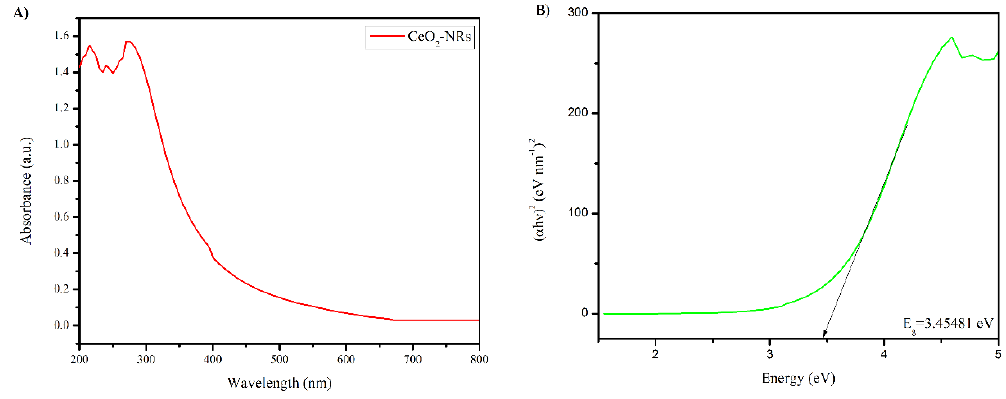
Figure 3. ( A ) UV-VIS spectrum of CeO 2 -NRs and ( B ) the Tauc plot for the band gap ( E g ).